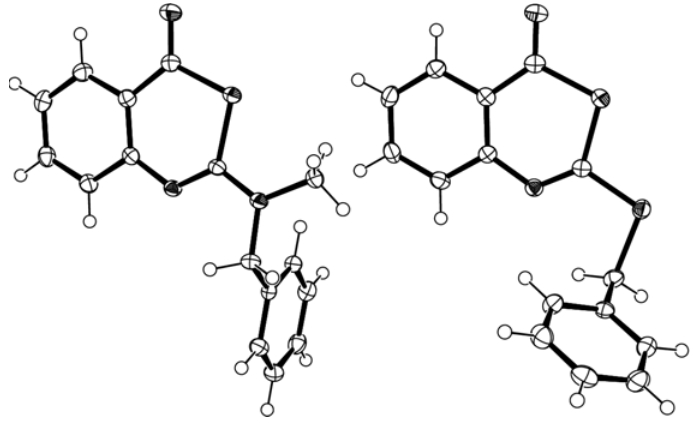
Figure 1. X-ray crystal structure of 2-( N -benzyl- N -methylamino)-4 H -3,1-benzothiazin-4- one 2g (left) and of 2-(benzylthio)-4 H -3,1-benzothiazin-4-one 5k